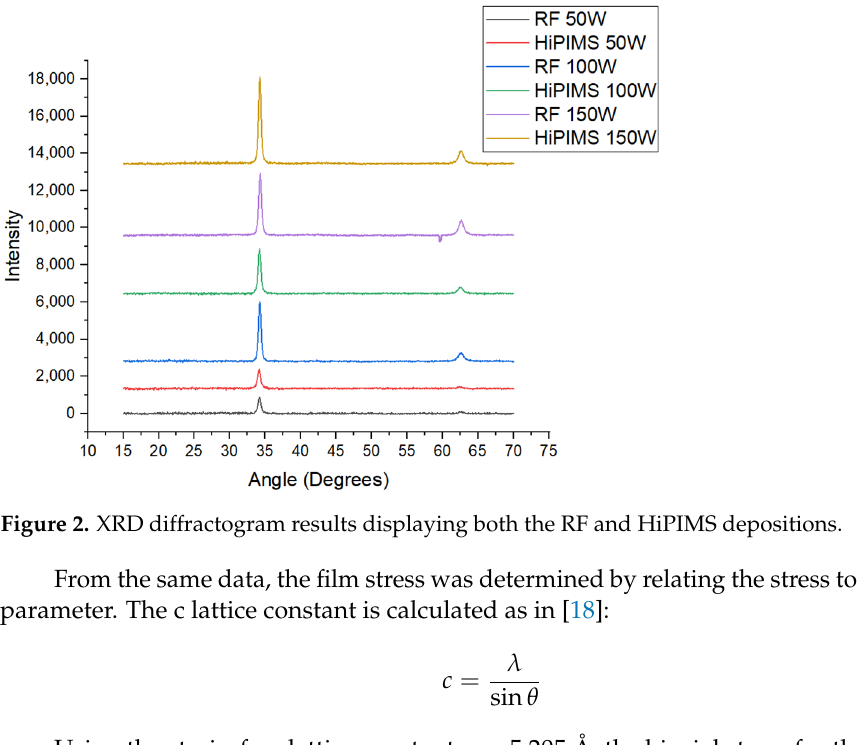
Table 2. Table of XRD, SEM, and AFM summary of